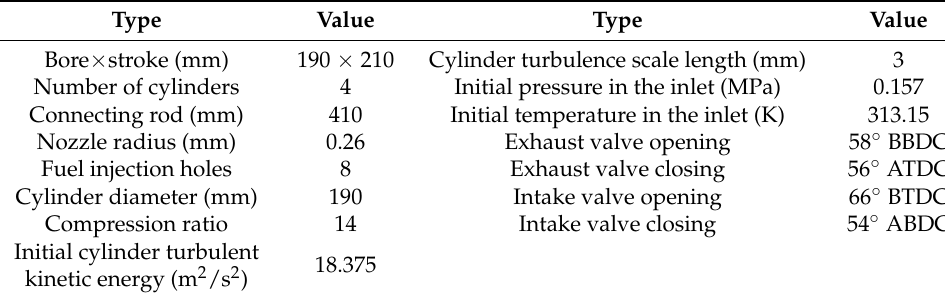
Table 2. Engine Specifications and Boundary Condition.